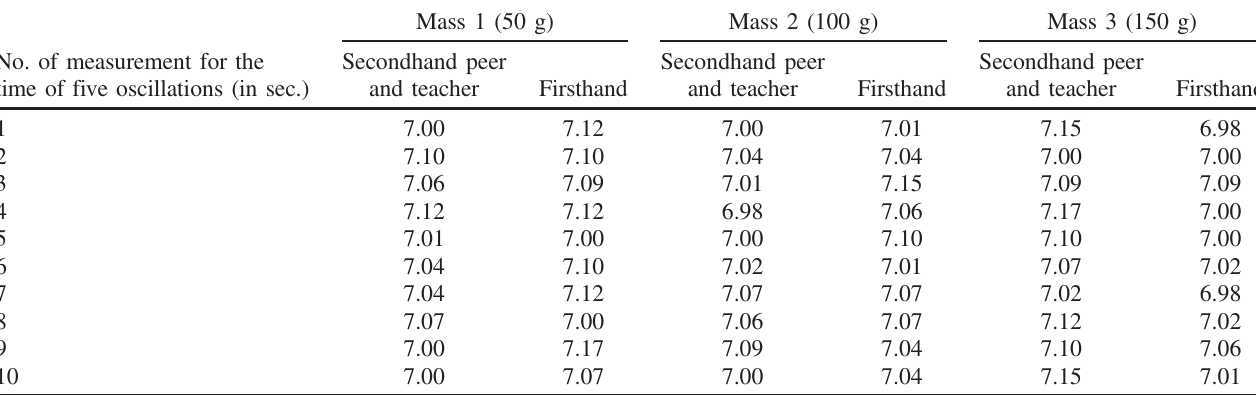
TABLE I. Dataset given to the secondhand peer and teacher group and example of a firsthand dataset.